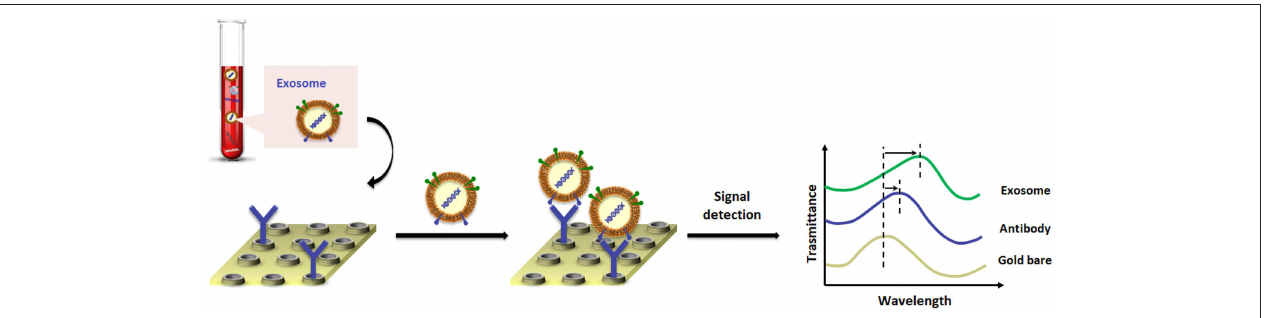
FIGURE 3 | Pictorial description of changes in transmission spectra for the exosome detection by nano-plasmonic exosome (nPLEX) assay.